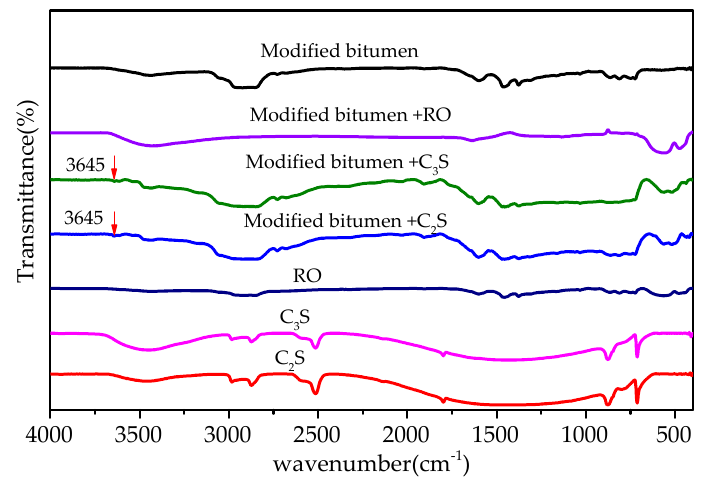
Figure 14. FT-IR of mixtures of bitumen–mineral components of steel slag.